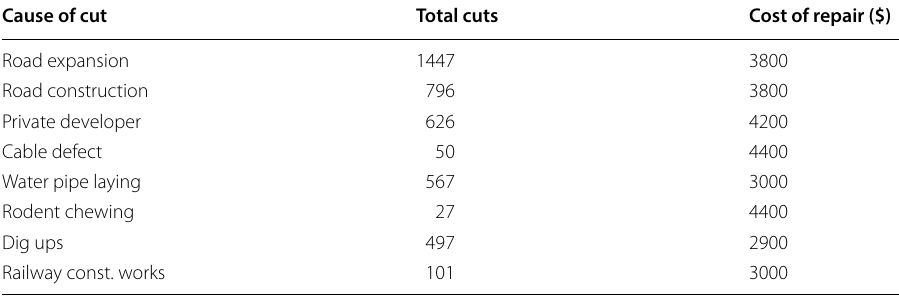
Table 2 Distribution of cause of cable cut against the cost of repairing each cable cut Cause of cut Total cuts